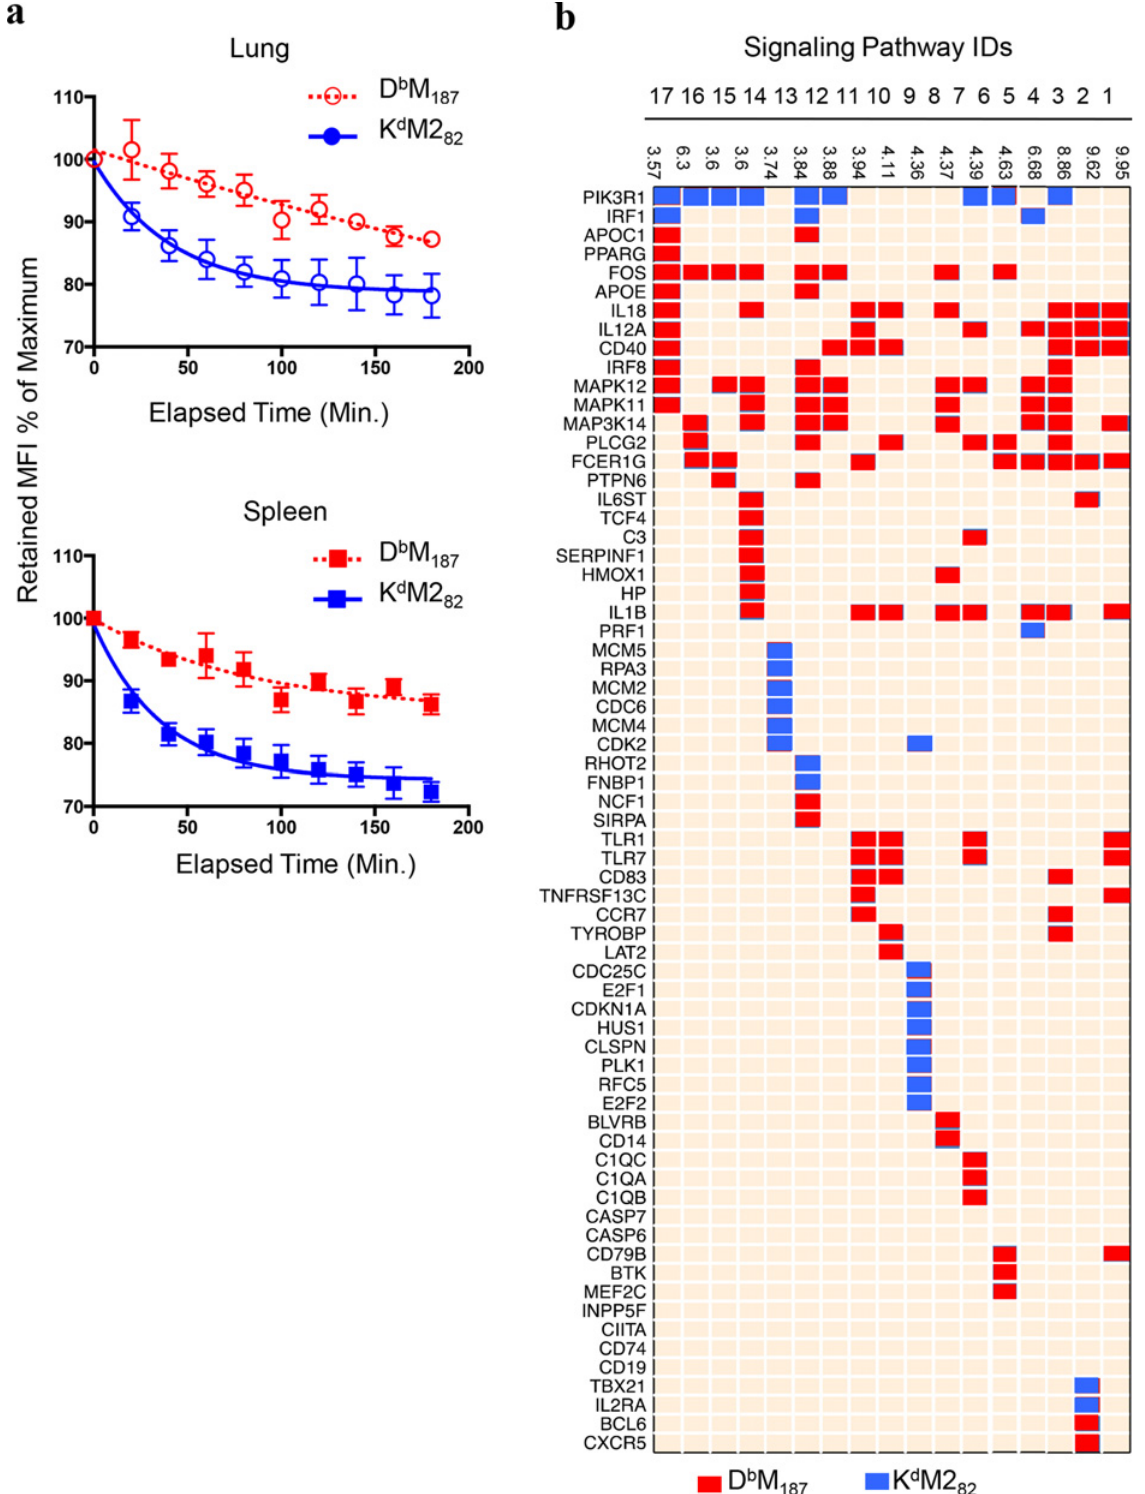
Fig 3. The D b M 187 T cells express high avidity TCR and signaling pathways promoting cytotoxic function. (a) The TCR avidity was assessed by dissociation of D b M 187 and K d M2 82 from CD8 T cells. CD8 T cells were labeled with pMHCs and assessed cell-bound median fluorescence intensity (MFI) at indicated time point by flow cytometry. The MFI at 0 min was defined as the maximum measurement (100%). Data were analyzed with one-phase